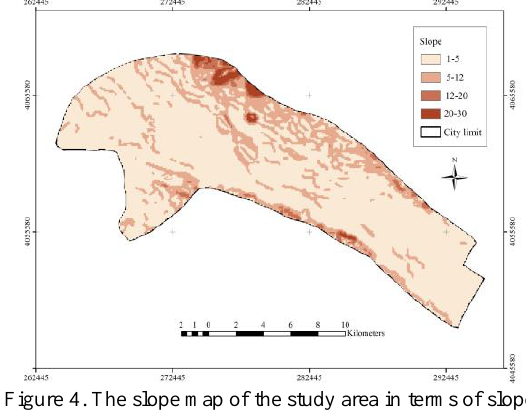
Figure 4. The slope map of the study area in terms of slope percentage